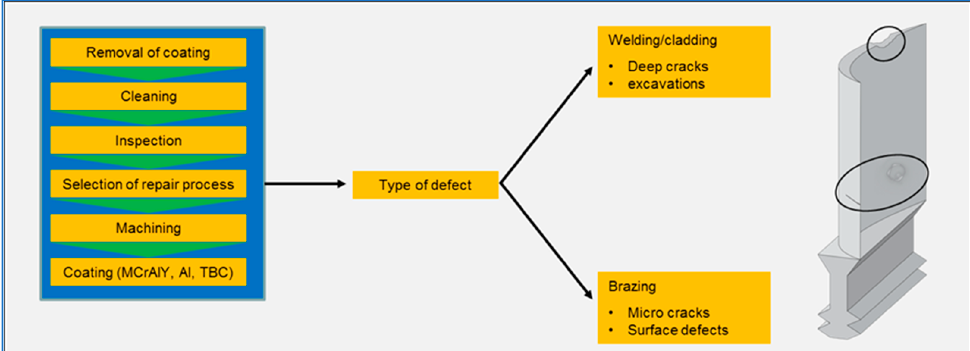
Figure 1. Conventional process chain for repairing turbine blades [10].